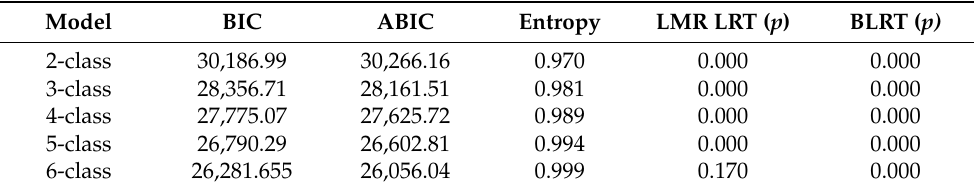
Table 2. Latent class analysis model fit